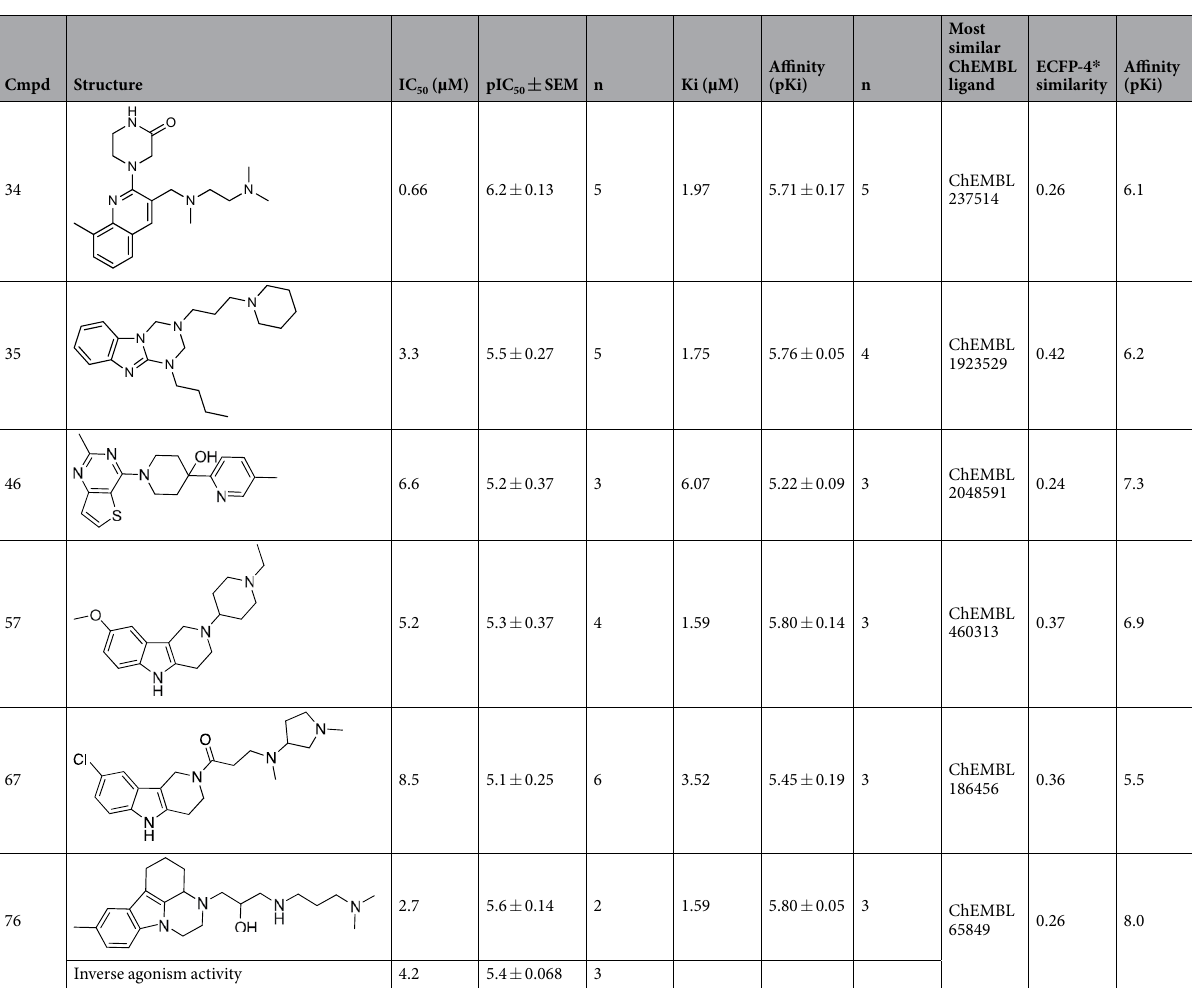
Table 1. Identified H 3 receptor ligand structures, potencies and most similar ChEMBL ligand. * ECFP-4 2D topological similarity.